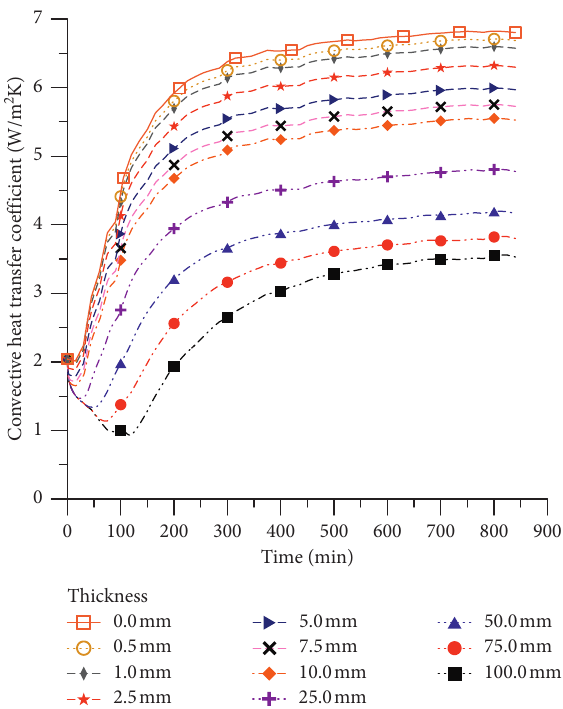
Figure 9: Radiation heat transfer coefficient during the heating process for different ceramic fiber thicknesses.